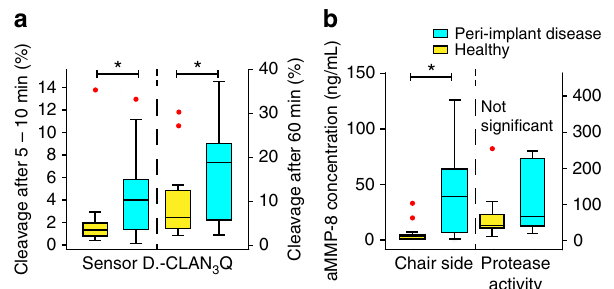
Fig. 6 Sensor performance in comparison to commercially available MMP diagnostics in saliva or sulcus fl uid collected from patients with peri-implant disease (de fi ned as mucositis or peri-implantitis; n = 19) and healthy control ( n = 14). a Cleavage of the sensor in % after 5 – 10 and 60 min of incubation in saliva. b Active MMP-8 (aMMP-8) in sulcus fl uid (chair-side test) and as measured from saliva (QuickZyme MMP-8 activity test). Box-and-whisker plots show the median ( solid line ), the box contains the middle 50% of values and the whiskers show the lower and upper 25% of the data, respectively. Outliers (not used for the analysis) are shown as red dots . Asterisks indicate statistical difference as assessed by a t -test ( p < alone (Fig. 3) but hardly any cleavage when the same PCL was